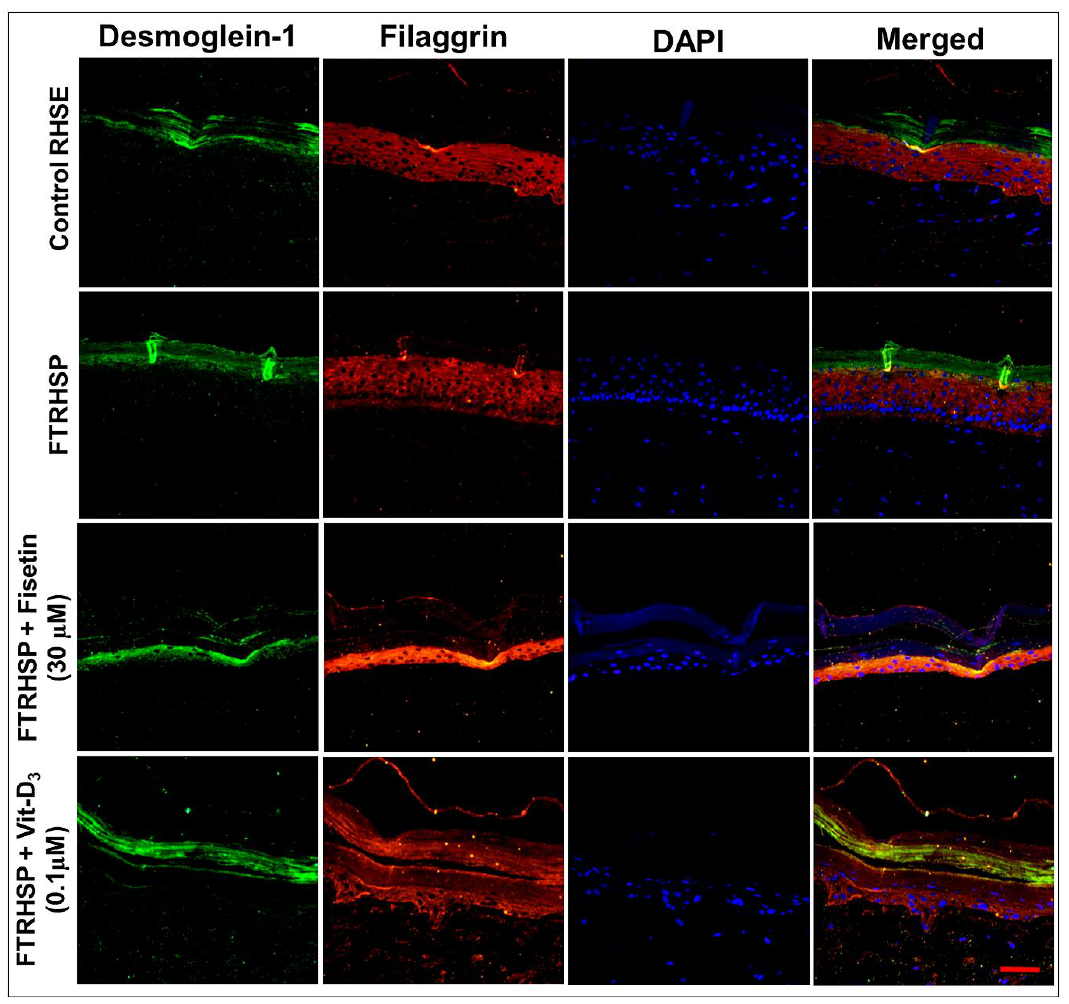
Figure 9. Representative immunofluorescent photomicrographs showing the protein expression levels of differentiation (filaggrin) and desmosomal (desmoglein-1) protein markers in control RHSE and FTRHSP under different treatment conditions versus fisetin or Vit-D 3 -treated FTRHSP tissues. Results are representative of three independent experiments each performed in quadruplicate and comparing control RHSE vs. FTRHSP treated groups. Data green (Dsgl-1); red (filaggrin), blue (DAPI) and mixed is merged representation. Dsgl-1 = desmoglein- 1. Scale bar = 20 μm.